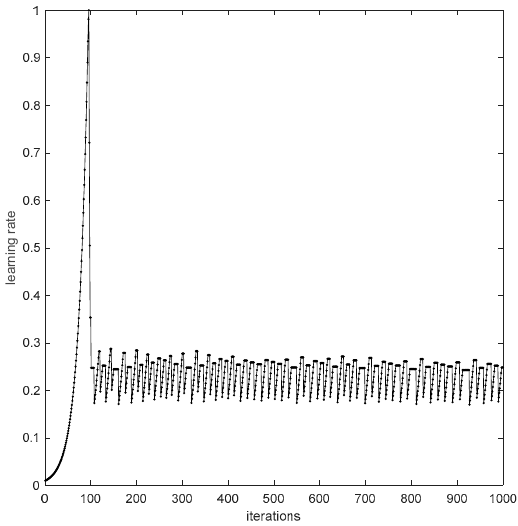
Figure 8. Learning rate change curve.